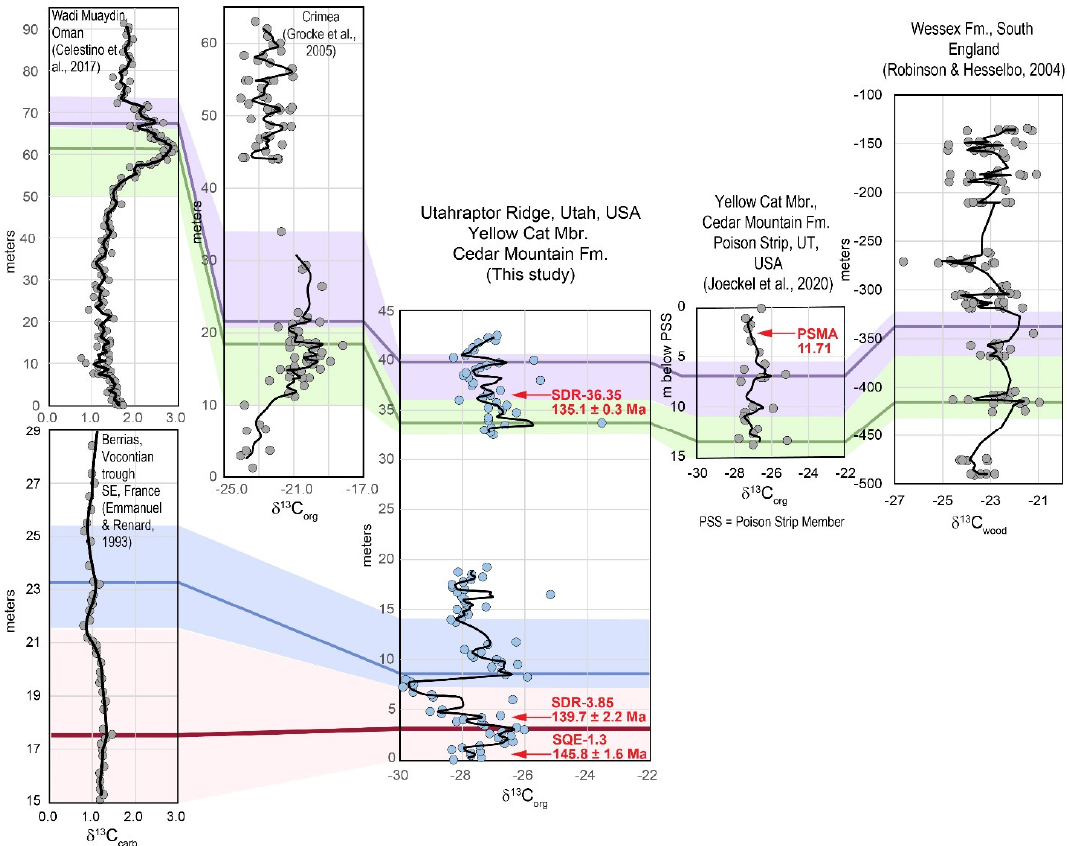
Figure 7. Comparison of new composite chemostratigraphic profile from Utahraptor Ridge with profiles from nearby Poison Strip, Utah (see Figure 1), as well as Oman, France, Crimea, and Eng- land [21,28,30,31] The correlation of the Valanginian carbon isotope excursion by Robinson and Hesselbo [30] has been here further subdivided into the upper and lower δ 13 C peaks.